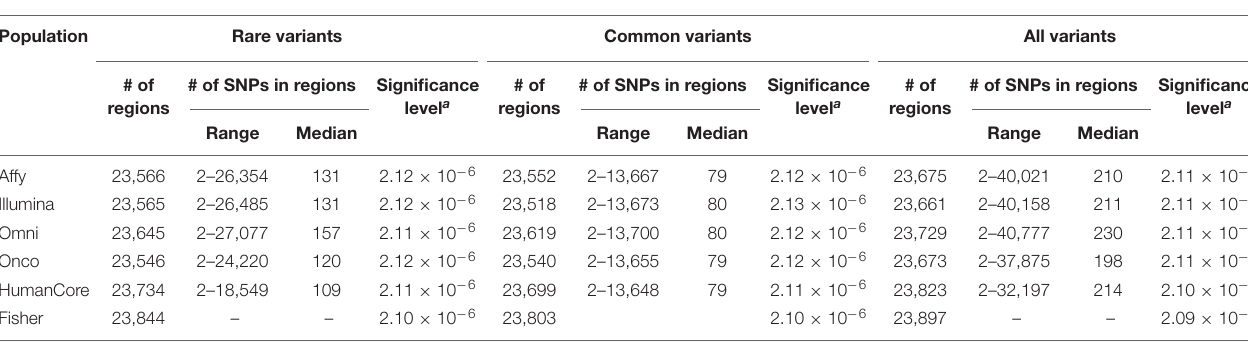
FIGURE 1 | Replication of 18 GWAS identified SNPs using fastSKAT. The p -values of fastSKAT were based on Fisher’s method combining its testing p -values from the same NHS and HPFS populations used in previous publications. TABLE 3 | Total number of regions and genetic variants tested in each